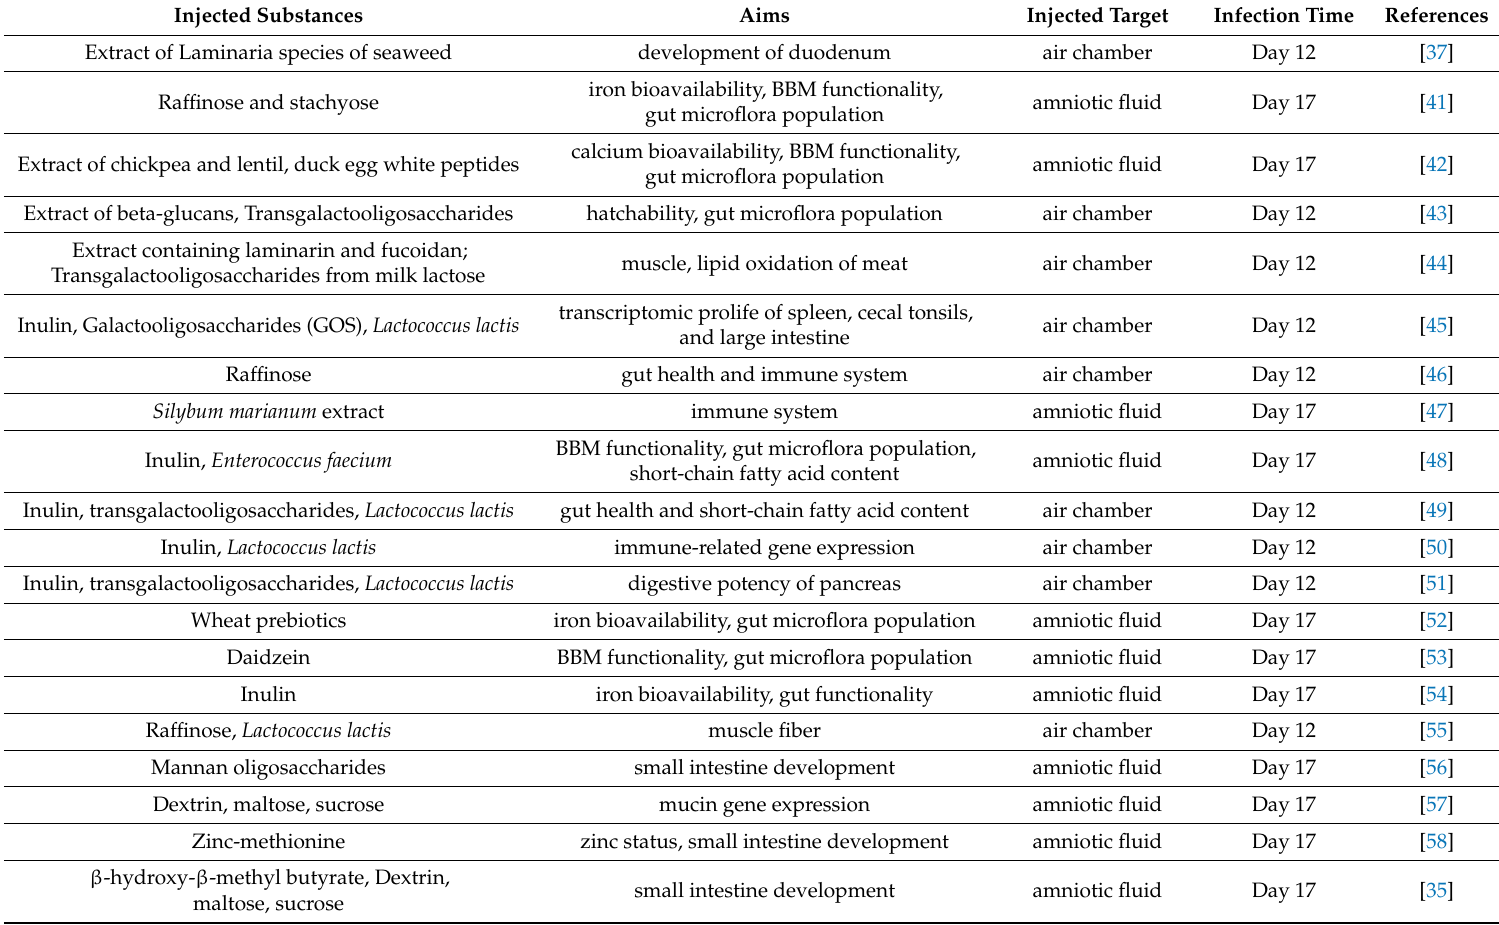
Table 1. Studies of in ovo nutrients administration. BBM: brush border